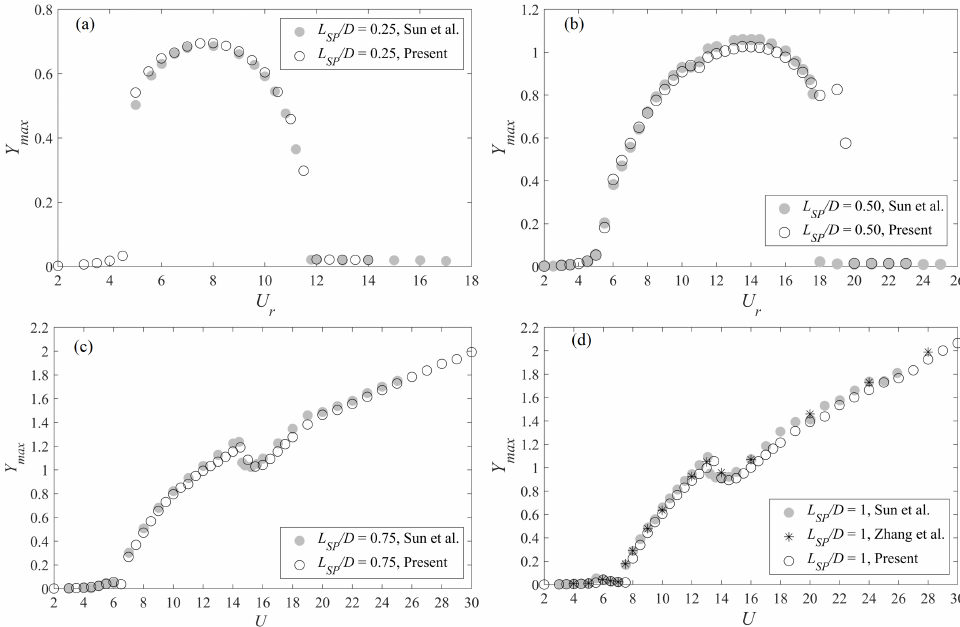
Figure 7. Comparison of numerical results between the present study and previous numerical investigations (Sun et al. [32], Zhang et al. [38]) for the normalized maximum transverse displacement Y max as a function of the reduced velocity U r . The current numerical simulations are of the FIV response of a cylinder-plate assembly with various plate lengths L SP / D for Re = 100, m ∗ = 10, and ζ =